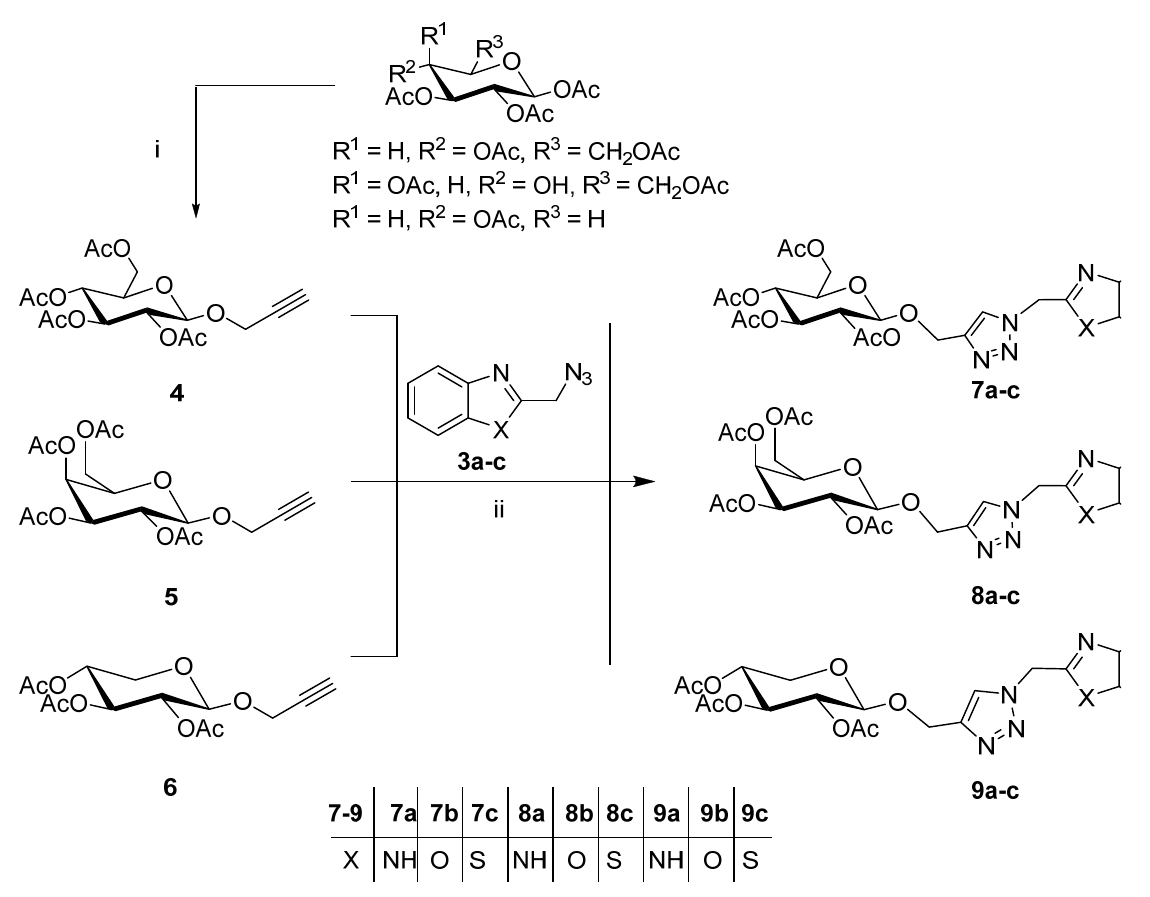
Figure 3. Synthetic procedure: (i) Propargyl alcohol, BF3.Et2O, CH2Cl2, rt., (ii) CuL3Br, 2-butanol, rt, 48 h.